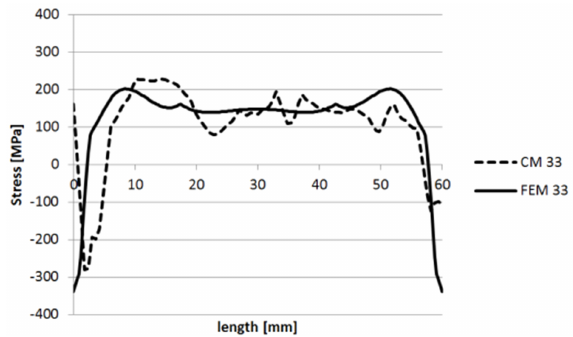
Figure 50. Stress levels in 33 direction along the AB line